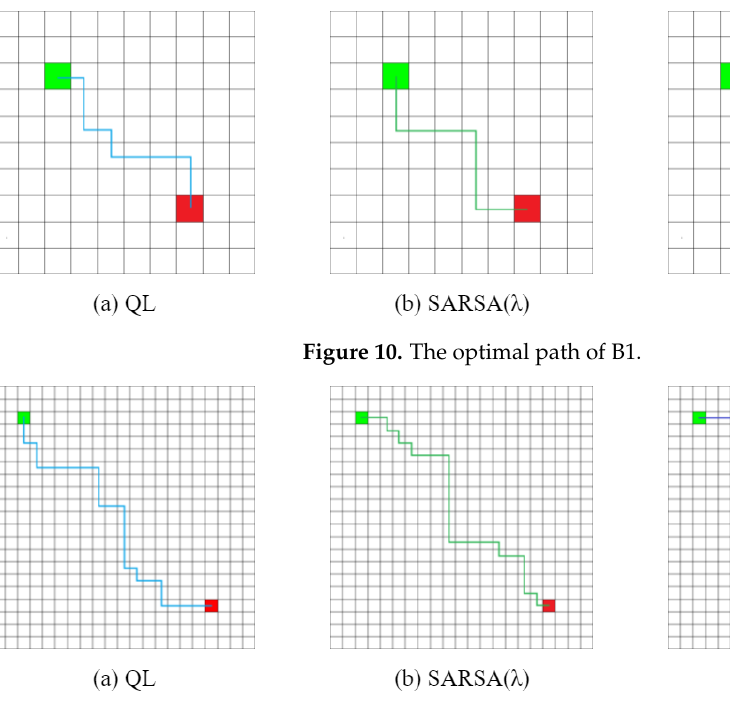
Figure 10. The optimal path of B1.